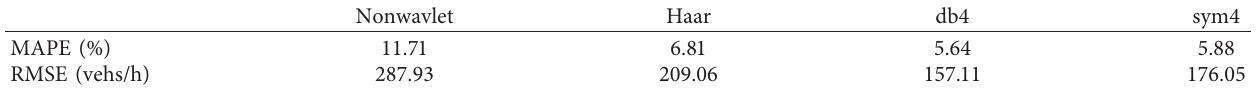
Table 3: The performances of different mother wavelets.